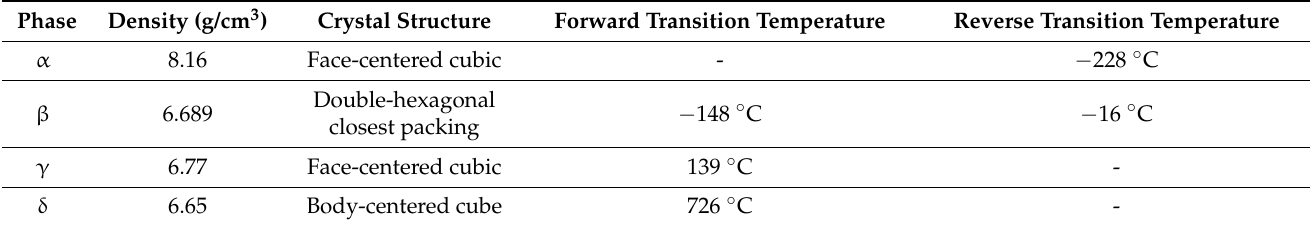
Table 1. Allotrope of